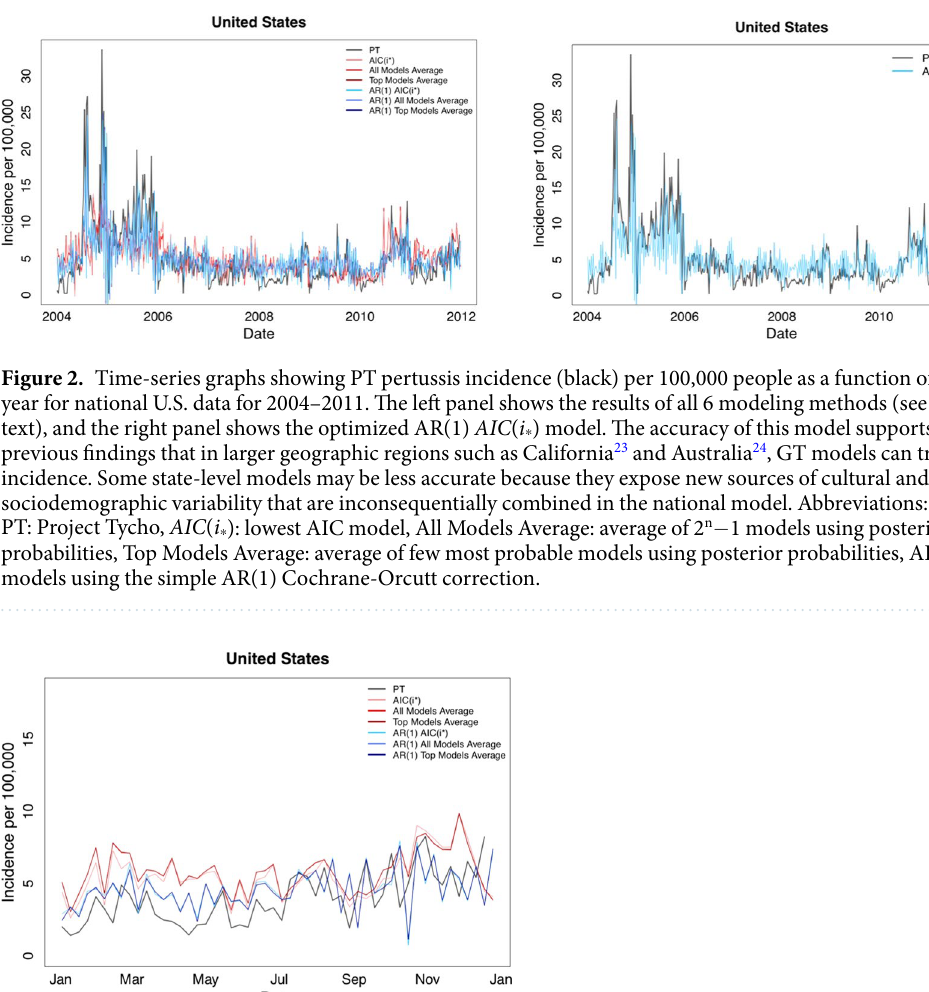
(adjusted R 2 = 0.1673). The average adjusted R2 across all 50 states and the District of Colombia was 0.0735. Examples are shown in Fig. 4. There were notable differences in search terms that were included in each region’s AR(1) AIC ( i For example, the Spanish terms “tos ferina” and “coqueleche” appeared only in the U.S., California, and New York AR(1) AIC ( i ) models. The variability between independent variables in all 52 of the AR(1) AIC ( i * els illustrates how the density of search terms was not uniform throughout the country and among states (see Supplemental Table 1). We also observed a spectrum of regional differences between the 52-week forecasting RMSE computations (see Fig. 5b) as some models forecasted the PT incidence data better than others. These RMSE values ranged from 0.0155 (Georgia) to 0.6238 (North Dakota) with a mean of 0.1808. The differences observed in RMSE values and model accuracy (Fig. 4) piqued our curiosity; might state-variable sociodemographic factors be responsible for some regional GT models working much better than others? A linear model was constructed incorporating state sociodemographic characteristics as independent variables and the 52-week forecasting RMSE values as the dependent variable. Notable associations are summa- rized in Table 4. The variables with the largest corresponding coefficients, i.e., having an impact on the similarity between GT forecasting and PT data were state population, number of immigrants, percent of the population aged 20–49 years, birth rate, and percent with a bachelor’s degree. Other variables had smaller coefficients such as average household size, percent in poverty, and percent with a job in the health sector (healthcare practitioners/technical occupations and healthcare support occupations). The sign on each coefficient shown in Table 4 illustrates the variable’s directional effect where negative coefficients correspond to smaller RMSE values (i.e., a more accurate